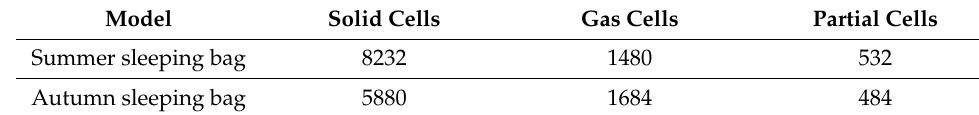
Table 3. Number of cells in 3D models of the tested sleeping bags.